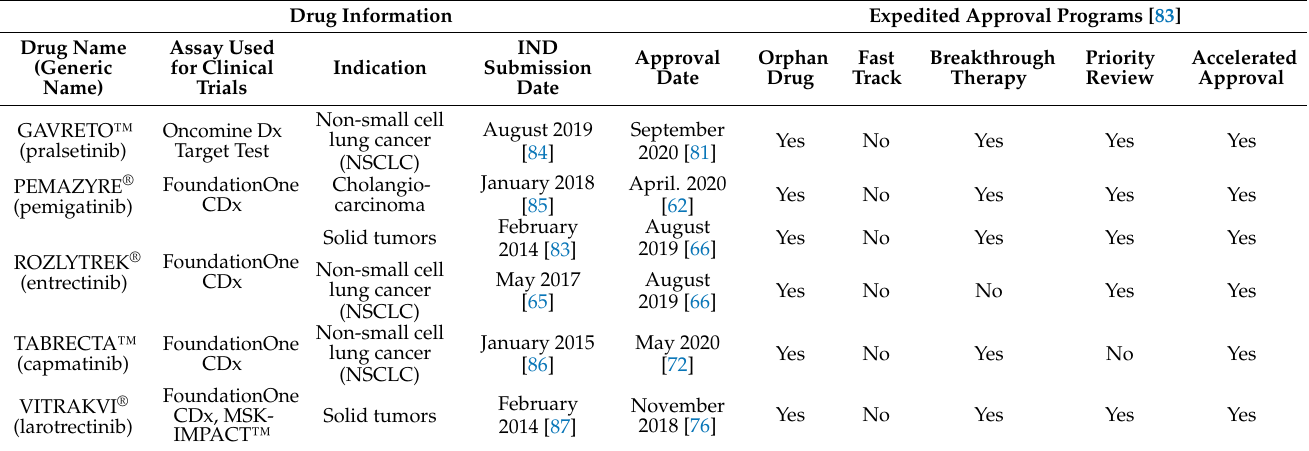
Table 4. Association between the FDA’s expedited approval programs and the new drugs identified by the three tumor profiling tests. To a greater or lesser extent, all the new drugs identified by the tests were found to have succeeded in speeding up the review process by utilizing a combination of the expedited approval